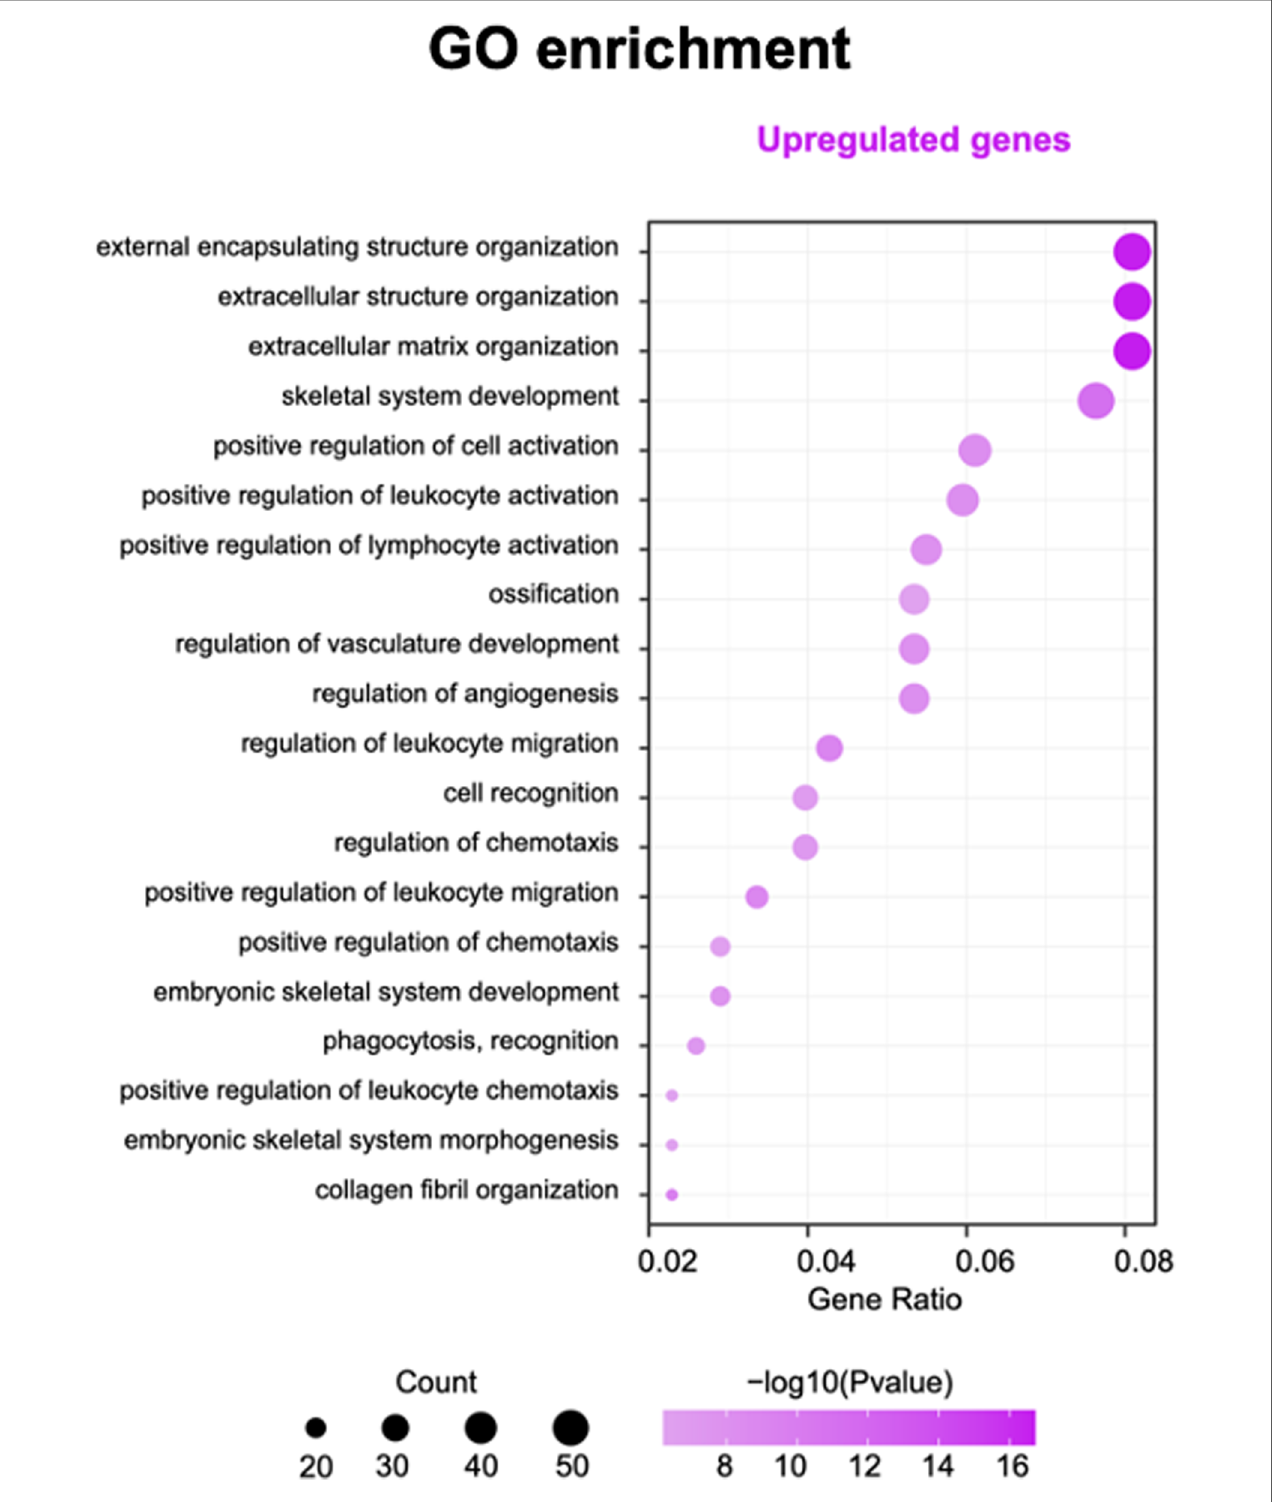
FIGURE 3 The top 10 enrichment GO (gene ontology) pathway